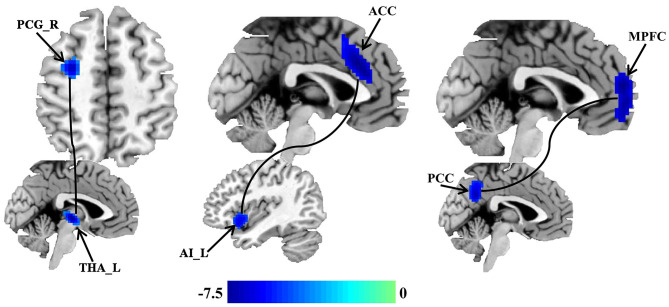
Disrupted resting-state functional connectivities in patients with migraine without aura. Seed based whole brain resting-state functional connectivities analyses of PCC, THA, and AI were performed, and two-sample t-tests were used to identify the significant differences in functional connectivities between patients with migraine without aura and healthy control groups. Seed-based functional connectivity analyses identified disrupted functional connection between the THA and left precentral gyrus (PCG), between the AI and anterior cingulate cortex (ACC), and between the PCC and medial prefrontal cortex (MPFC) in patients with migraine without aura.